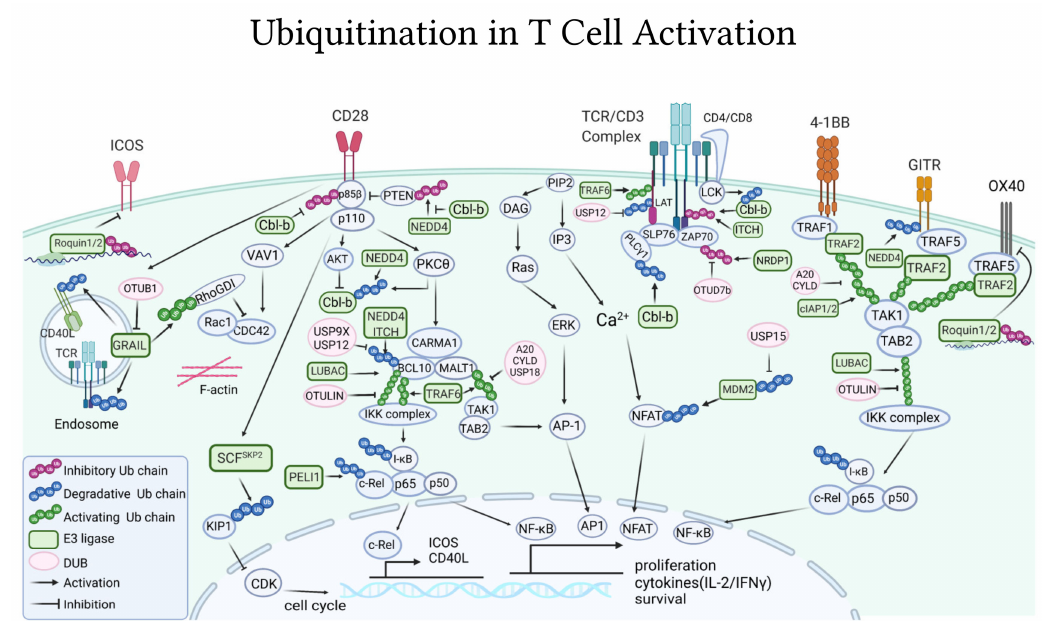
Figure 2. Ubiquitination in key T-cell activation pathways. T cells are activated upon antigen recognition by TCR complex (signal 1) and simultaneous engagement of co-stimulatory receptor such as CD28, 4-1BB, and ICOS (signal 2). These dual pathways integrate to trigger numerous signaling pathways that converge in the activation of NF- κ B, NFAT, and AP-1 transcription factors that drive the genetic program for T-cell survival, proliferation, differentiation, and cytokine production. Various ubiquitin E3 ligases and deubiquitinases regulate these essential cascades using different ubiquitin chains, some of which activate (green chains), inhibit (purple chains), or degrade, via the lysosome or proteosome, (blue chains) the protein substrates. Ub: ubiquitin; DUB: deubiquitinase; AKT: serine/threonine-protein kinase/protein kinase B; AP-1: activator protein 1; BCL10: B cell lymphoma/leukemia 10; CARMA1: caspase recruitment domain-containing membrane-associated guanylate kinase protein-1; Cbl-b: casitas B-Lineage Lymphoma proto-oncogene B; CD40L: CD40 antigen ligand; CDC42: Cell division cycle 42; CDK: cyclin-dependent kinase; cIAP1/2: cellular inhibitor of apoptosis protein 1/2; CYLD: CYLD lysine 63 deubiquitinase; DAG: diacylglycerol; ERK: extracellular signal-regulated kinases; GITR: glucocorticoid-induced TNFR-related protein; GRAIL: gene related to anergy in lymphocytes protein; ICOS: inducible T-cell costimulator; IFN γ : interferon gamma; IKK complex: I κ B kinase complex; IL2: interleukin 2; IP3: inositol trisphosphate; ITCH: itchy E3 ubiquitin protein ligase; I- κ B: inhibitor of nuclear factor kappa B; KIP1: cyclin-dependent kinase inhibitor 1B; LAT: linker for activation of T cells; LCK: lymphocyte-specific protein tyrosine kinase; LUBAC: linear ubiquitin chain assembly complex; MALT1: mucosa-associated lymphatic tissue 1; MDM2: mouse double minute 2 homolog; NEDD4: neural precursor cell expressed developmentally down-regulated protein 4; NFAT: nuclear factor of activated T-cells; NF- κ B: nuclear factor kappa-light-chain-enhancer of activated B cells; NRDP1: neuregulin receptor degradation protein-1 (also RNF41, ring finger protein 41); OTUB1: OTU domain-containing ubiquitin aldehyde-binding protein 1; OTUD7b: OTU deubiquitinase 7B; OTULIN: OTU deubiquitinase with linear linkage specificity; OX40: tumor necrosis factor receptor superfamily member 4 (also TNFRSF4); PIP2: phosphatidylinositol 4,5-bisphosphate; PKC θ : protein kinase C Theta; PLC γ 1: phospholipase C- γ 1; PTEN: phosphatase and tensin homolog; Rac1: rac family small GTPase 1; RhoGDI: Rho GDP-dissociation inhibitor; Roquin1/2: ring finger and CCCH-type zinc dinger somains 1/2; SCFSKP2: Skp1-Cullin-1-F-box (SCF) Cullin-Ring E3 ubiquitin ligase complex containing S-phase kinase associated protein 2 (SKP2); SLP76: lymphocyte cytosolic protein 2; TAB2: TGF-beta activated kinase 1 Binding Protein 2; TAK1: TGF-beta activated kinase 1 (also MAP3K7); TCR: T-cell receptor; TRAF1/2/5/6: TNF receptor associated factor 1/2/5/6; USP12/15/18/9X: ubiquitin specific peptidase 12/15/18/9 X-Linked, respectively; VAV1: vav guanine nucleotide exchange factor 1; ZAP70: ζ -chain associated protein 70. Illustration created using BioRender